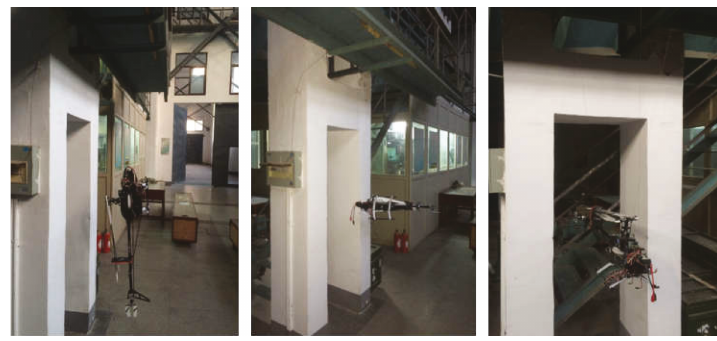
Figure 3: Measurement of the inertial moments. Table 1: Directly measured physical parameters of the Trex-600.